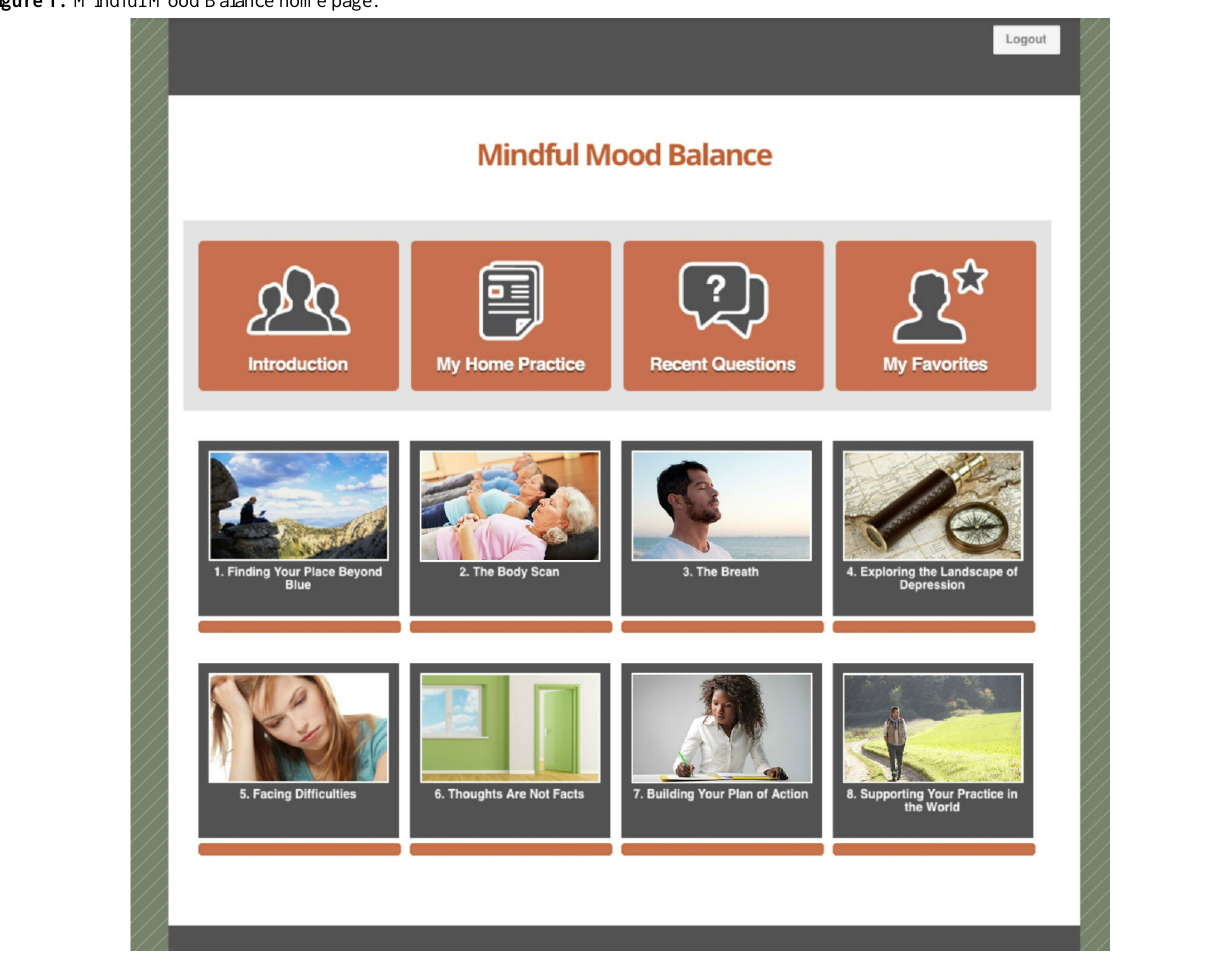
Figure 2. Three-minute coping breathing space completed during an MMB session with audio download